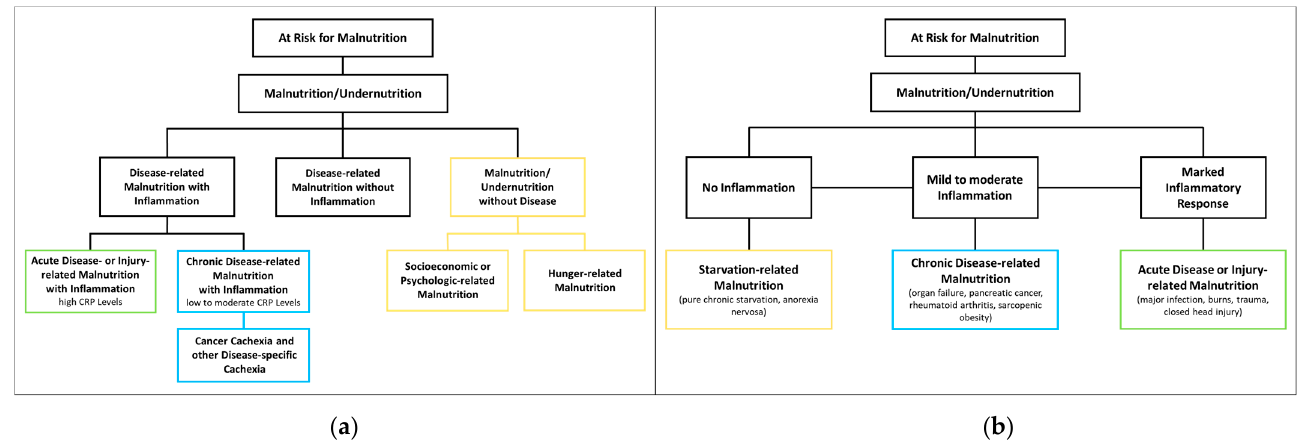
Figure 1. Classification of Malnutrition by (a) European Society of Clinical Nutrition and Metabolism (ESPEN) [8] and (b) American Society for Parenteral and Enteral Nutrition (ASPEN) [16] .